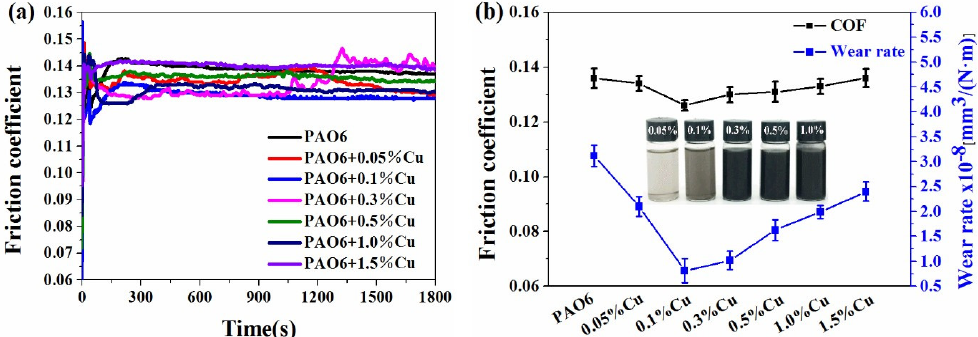
Figure 6. Friction curves ( a ) and wear rates ( b ) of steel/DLC friction pairs with different addition of Cu nanoparticles.